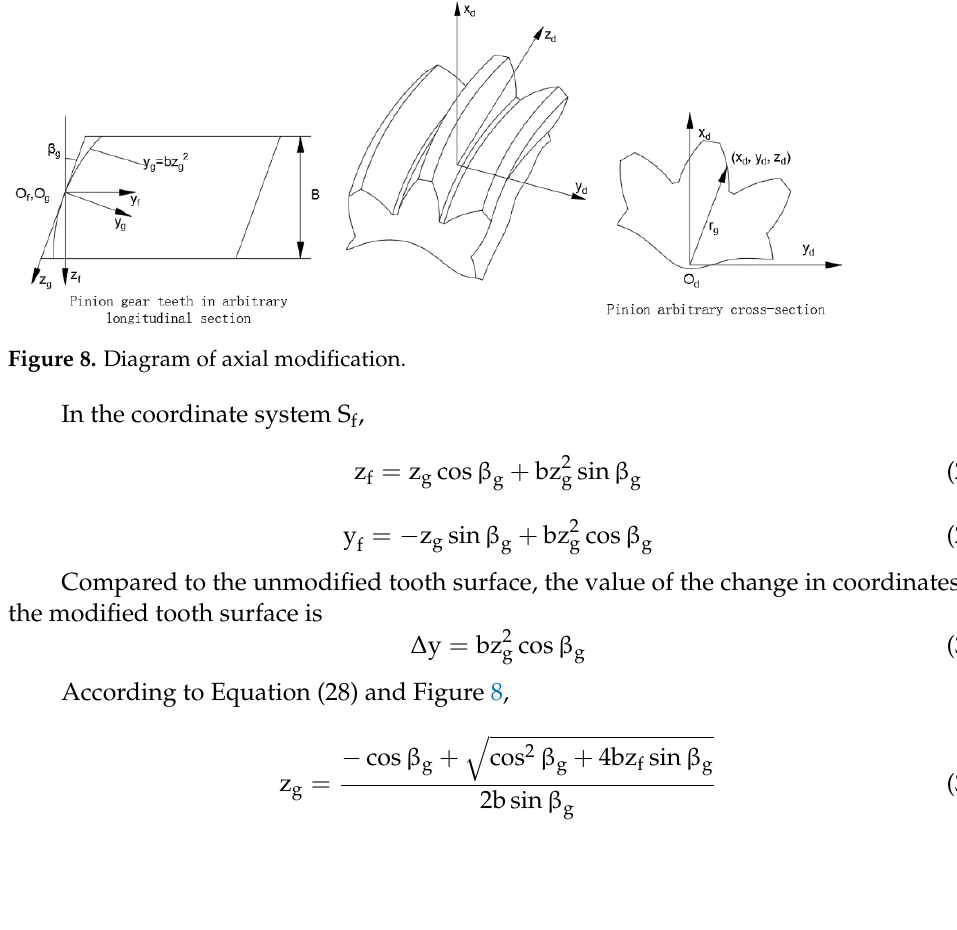
Figure 7. Pinion and rack meshing.